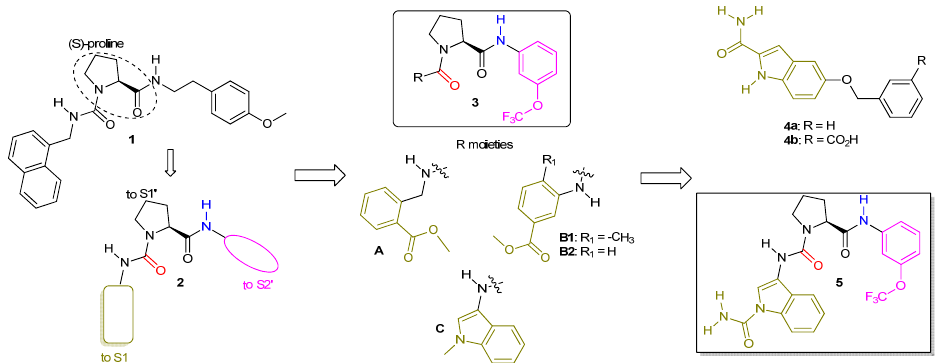
Figure 3. Evolution of KLK7 inhibitor 1 to FD selective inhibitor 5 . The solved co-crystal structure of molecule 3A with human FD revealed a bent conformation for 3A fitting into the U-shaped S1-S1 ′ -S2 ′ FD cleft, analogous to the 1 -KLK7 pair. The ortho-positioned ester moiety of molecule 3A acted as a hydrogen bond acceptor interacting with the Arg 218 side chain while the -OCF 3 group, being perpendicular relative to the benzene ring plane, was engaged in a hydrophobic interaction. Moving the ester moiety at the meta-position (molecules 3B1 and 3B2 ) required the concomitant presence of a small alkyl group R 1 at the ortho-position for FD inhibitory activity (IC 50 of 3B1 was 17 µM while 3B2 was inactive). The ortho- methyl group enforces a properly distorted (non-planar) geometry around the phenyl ring, facilitating its entrance into the narrow S1 pocket. Molecule 3C (IC 50 = 20 µM) has an indole ring as the S1 binding moiety where the -NCH 3 is found in close proximity to the Arg 218 side chain and to overlap with the indole carbon of molecules 4 carrying a primary amide group.